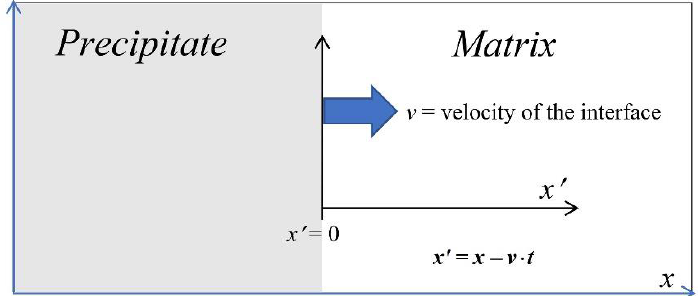
Figure 1. Relationship between the stationary ( x ) and the moving ( x ′) reference frames for a precipitate growing at the expense of the matrix.